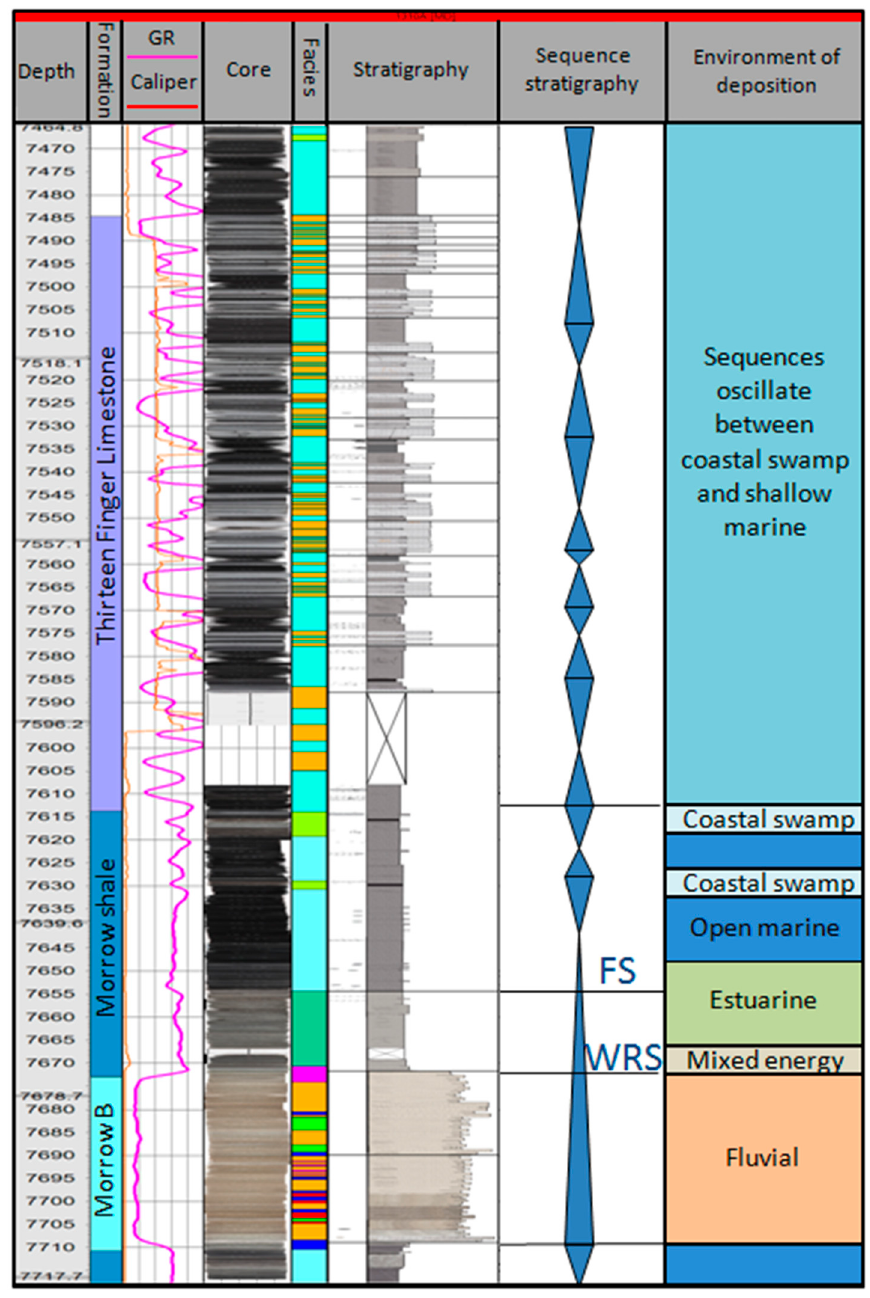
Figure 12. Sequence stratigraphy of the FWU cored reservoir and caprock interval in well 13-10A. From left to right columns illustrate depth, formation, gamma ray (GR) signature, facies, stratigraphic column, sequence stratigraphic surfaces, and depositional environments. Narrow points at the apex of blue triangles represent marine flooding surfaces, triangles narrowing upwards are high-stand systems tracts, while those broadening upwards are low-stand systems tracts. WRS = possible wave ravinement surface; SF = flooding surface.